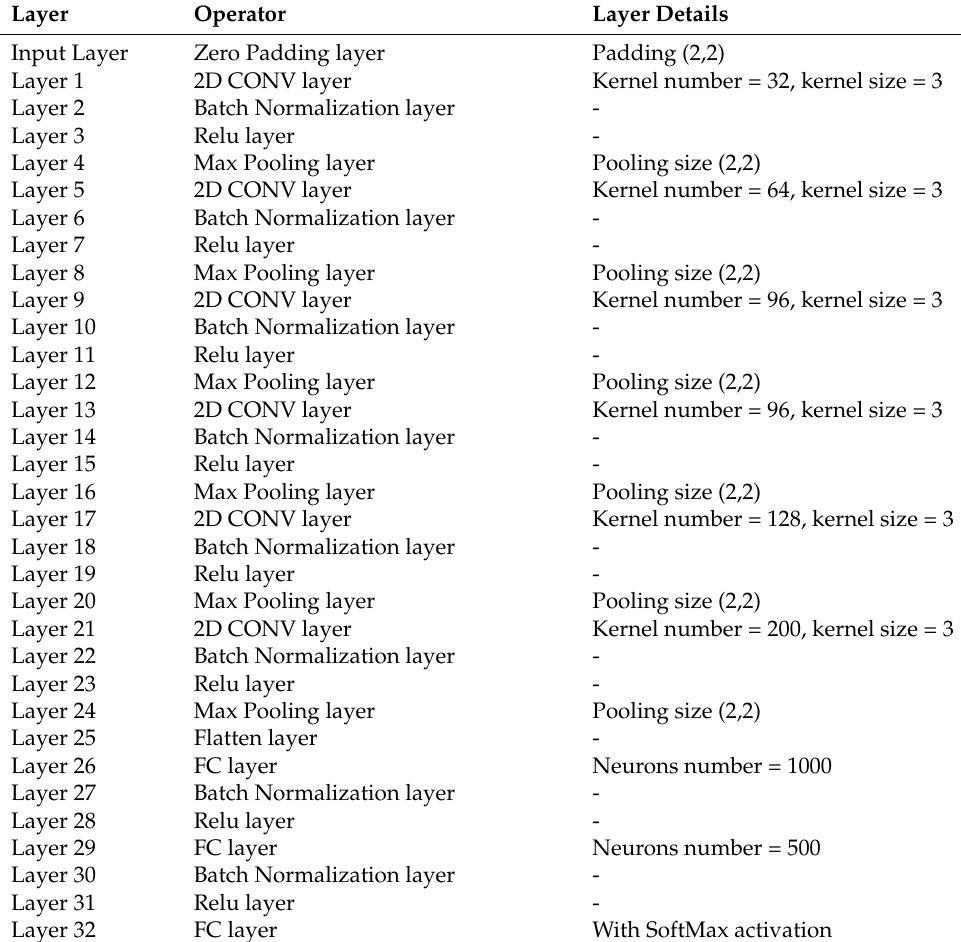
Table 7. The proposed CNN512 layers